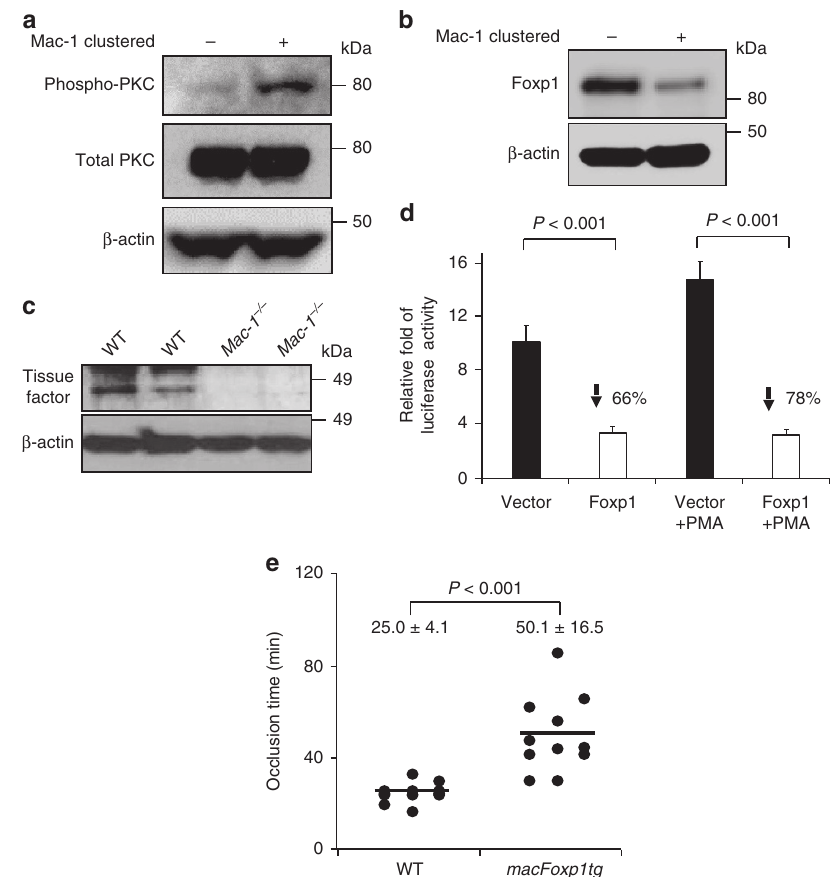
Figure 4 | ‘Outside-in’ Mac-1 signalling. ( a ) Phosphorylation of PKC-delta in Mac-1-clustered ( þ ) and non-clustered ( (cid:2) ) THP-1 monocytic cells was examined by immunoblotting. ( b ) Expression of Foxp1 in Mac-1-clustered ( þ ) and non-clustered ( (cid:2) ) THP-1 monocytic cells was examined by immunoblotting. ( c ) TF expression of lipopolysaccharide-stimulated WTand Mac-1 (cid:2) / (cid:2) leukocytes was examined by western analysis using anti-TF and anti- b -actin antibodies (loading control). Full, uncropped blots for a, b and c can be found in Supplementary Fig.8. ( d ) TF expression in unstimulated and phorbol 12-myristate 13-acetate (PMA)-stimulated murine NIH/3T3 cells transfected with either Foxp1 or vector control pcDNA was quantified using a TF promoter activity assay. Data shown (mean ± s.d.) is from one of two independent experiments, and each experiment was performed in triplicate with three transfection wells. ( e ) Occlusion times following photochemical injury of the carotid artery in WT ( n ¼ 12) and macFoxp1tg ( n ¼ 11) mice (mean ± s.d.). P values are obtained by unpaired two-tailed t-